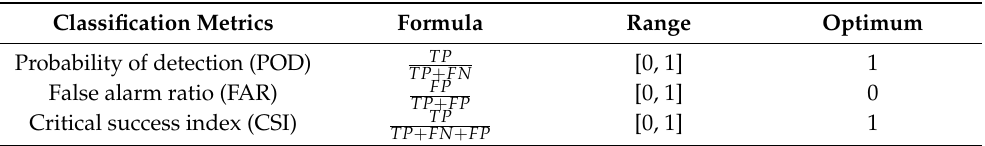
Table 2. Description of classification metrics used. TP denotes the number of true positive events, FN denotes the number of missing events, FP denotes the number of false-positive events, and TN denotes the number of true negative